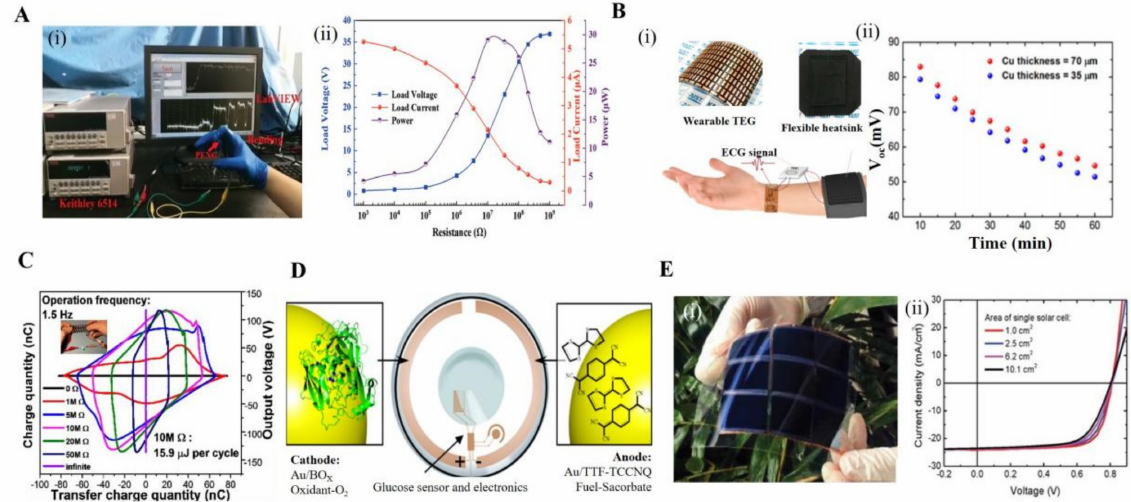
Figure 6. Several powered devices for wearable sensors based on 2D materials. ( A ): (i) Electrical signals generated by flexible piezoelectric nanogenerators when bent. (ii) The output voltage, current, and instantaneous power outputs dependence on different load resistance ranges [133]. Copyright 2021, Wiley-VCH. ( B ): (i) General schematic diagram of a thermogenerator self-powered wearable ECG system. (ii) System open-circuit voltage versus operating time variation [134]. Copyright 2018, American Chemical Society. ( C ): V–Q curves of a TENG under different loads. Illustration is photograph of using the integrated KP-SC (6 units; 3 devices in series) to light up a single commercial green LED under cycling stretching movement [135]. Copyright 2016, American Chemical Society. ( D ): Working of a glucose biofuel cell contact lens sensor, schematic diagram [136]. Copyright 2013, American Chemical Society. ( E ): (i) Optical image of an organic photovoltaic flexible assembly module. (ii) J–V curves of flexible photovoltaics of different areas [137]. Copyright 2021,